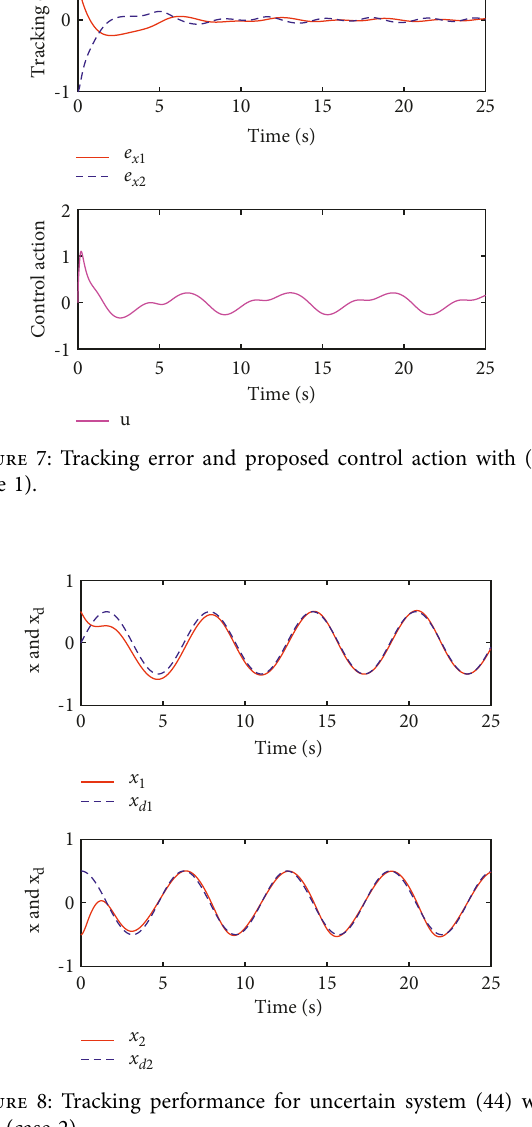
Figure 10: Profiles of CNN weights with